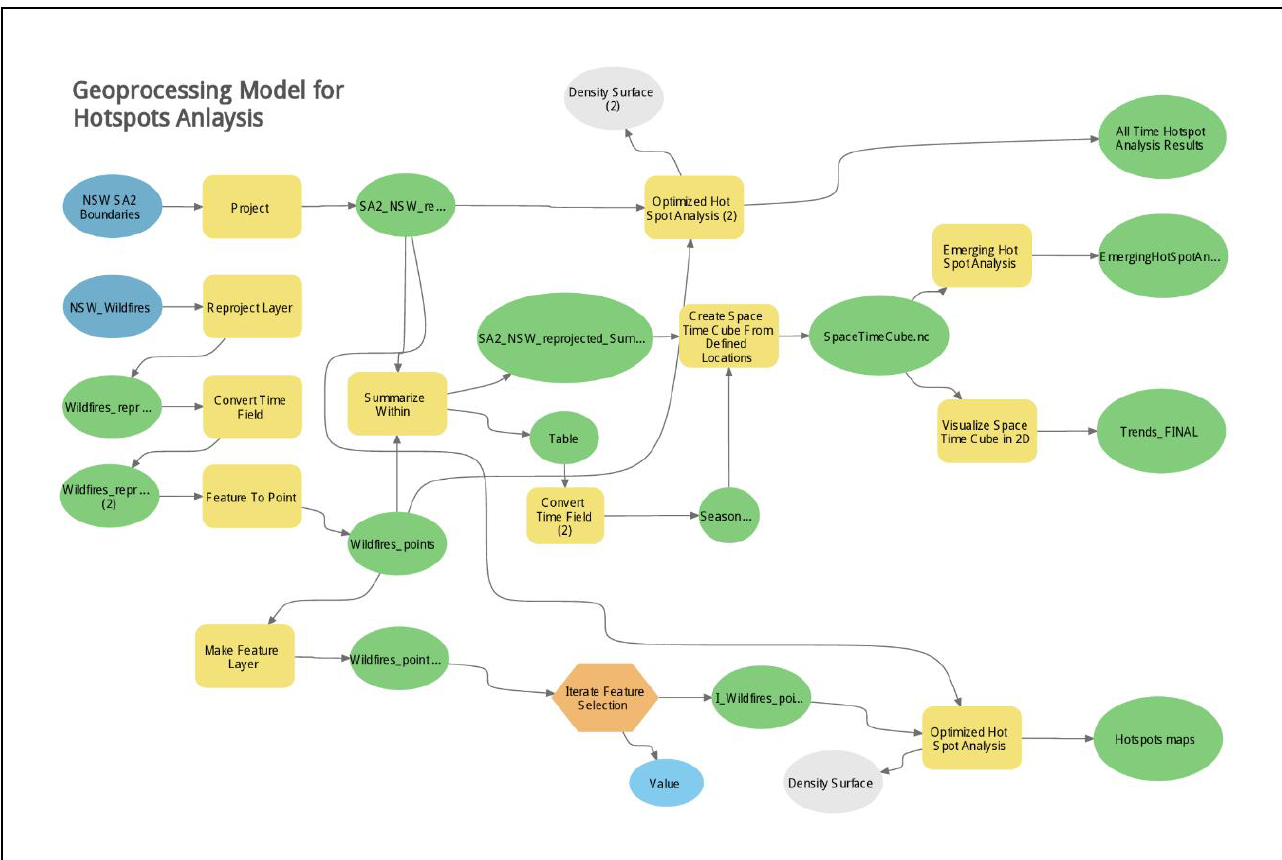
Figure 7. The geoprocessing model created with ArcGIS Pro’s ModelBuilder